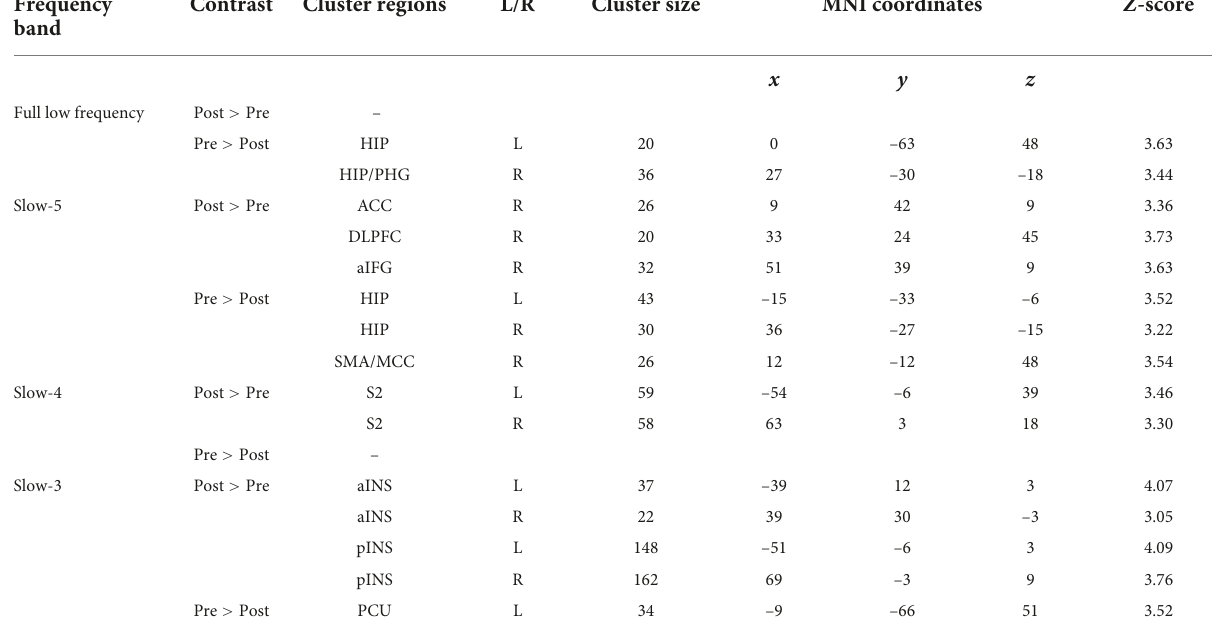
TABLE 2 Frequency-specific gFCD alternations in the VA